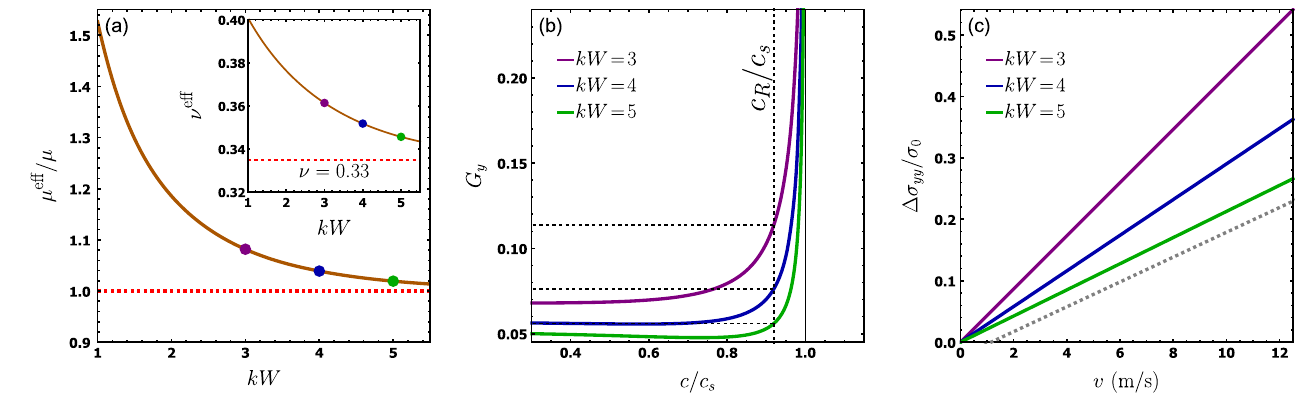
FIG. 3. Analytical results. (a) The effective shear modulus μ eff of the thicker block, in units of μ , vs the dimensionless wave number q ¼ kW , cf. Eq. (7). (Inset) The variation of the effective Poisson ’ s ratio ν eff ð q Þ with q ¼ kW . In both the main panel and the inset we used ν ¼ 0 . 33 , which is relevant for PMMA [49,70]. (b) The response function G , quantifying the effective bimaterial contrast y according to μ eff ð q Þ and ν eff ð q Þ (for the thicker block; the thinner one is represented by plane-stress conditions), corresponding to selected values of q ¼ kW . The corresponding values of the elastic moduli μ eff ð q Þ > μ and ν eff ð q Þ > ν are marked in panel (a) and its inset using the same color code. (c) Δ σ given in Eq. (8), normalized by the experimentally applied normal stress σ 0 ¼ 4 . 5 MPa, vs the yy ≃ 1237 m = s. The gray dashed line is the red line in Fig. slip velocity v , where the propagation velocity was set to c ¼ c R